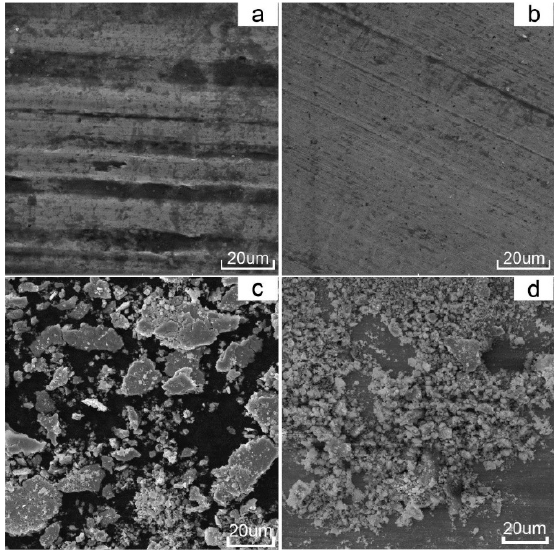
Figure 14. Worn surface micrographs of the Cr 13 Ni 5 Si 2 -based composite coating at ( a ) room temperature and ( b ) 500 °C; and wear debris at ( c ) room temperature and ( d ) 500 °C.